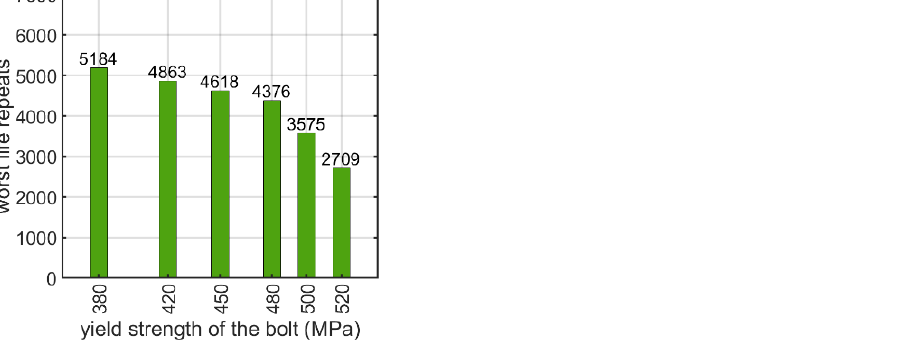
Figure 11. Number of logarithmic life repeats for parameterizing the yield stress of the prestressed bolt with a nut.